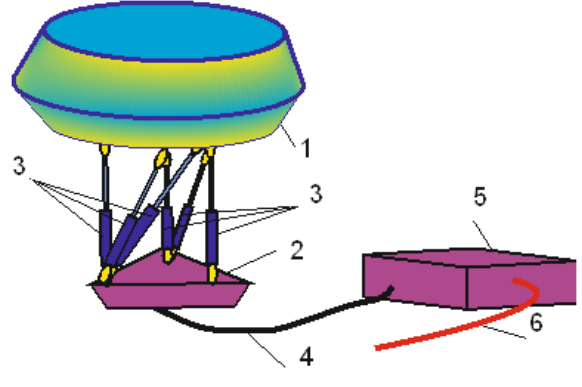
Figure 4 . Simplified diagram of the wave power